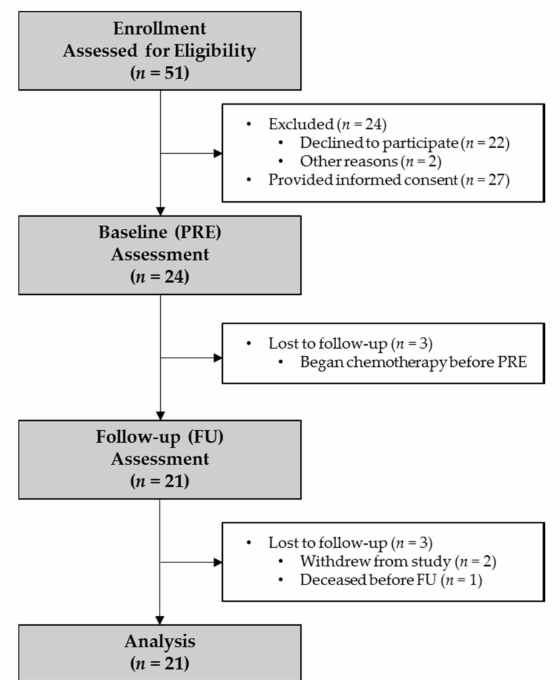
Figure 1. Study flow diagram. PRE, baseline visit; FU, one-month follow-up